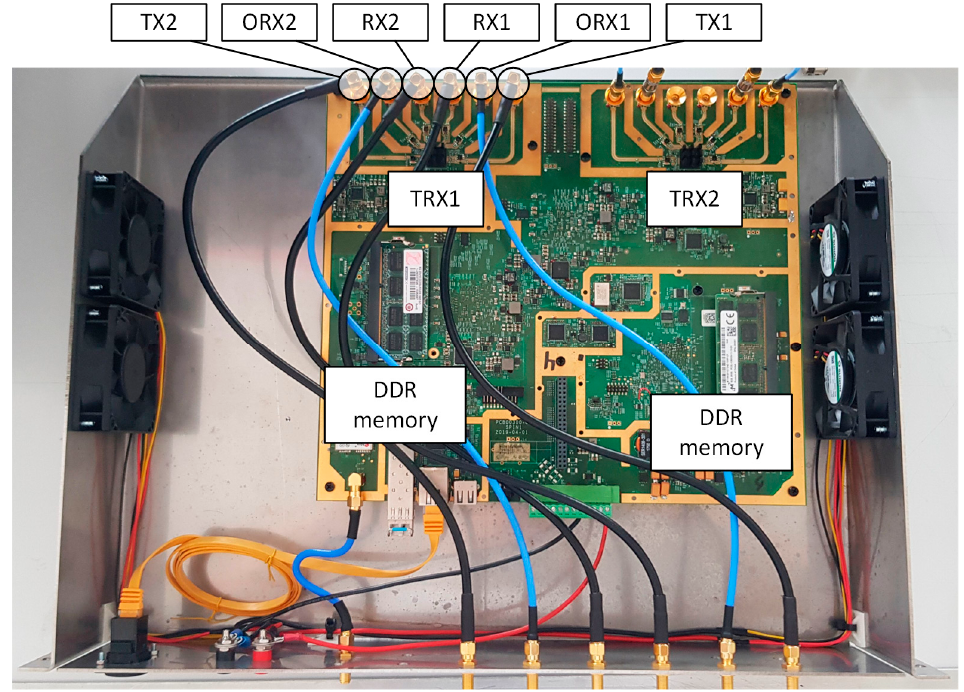
Figure 3. Test fixture with the UHP prepared for experiments. The RF front-end can be cable-connected. UHP test fixture without the RF front-end.